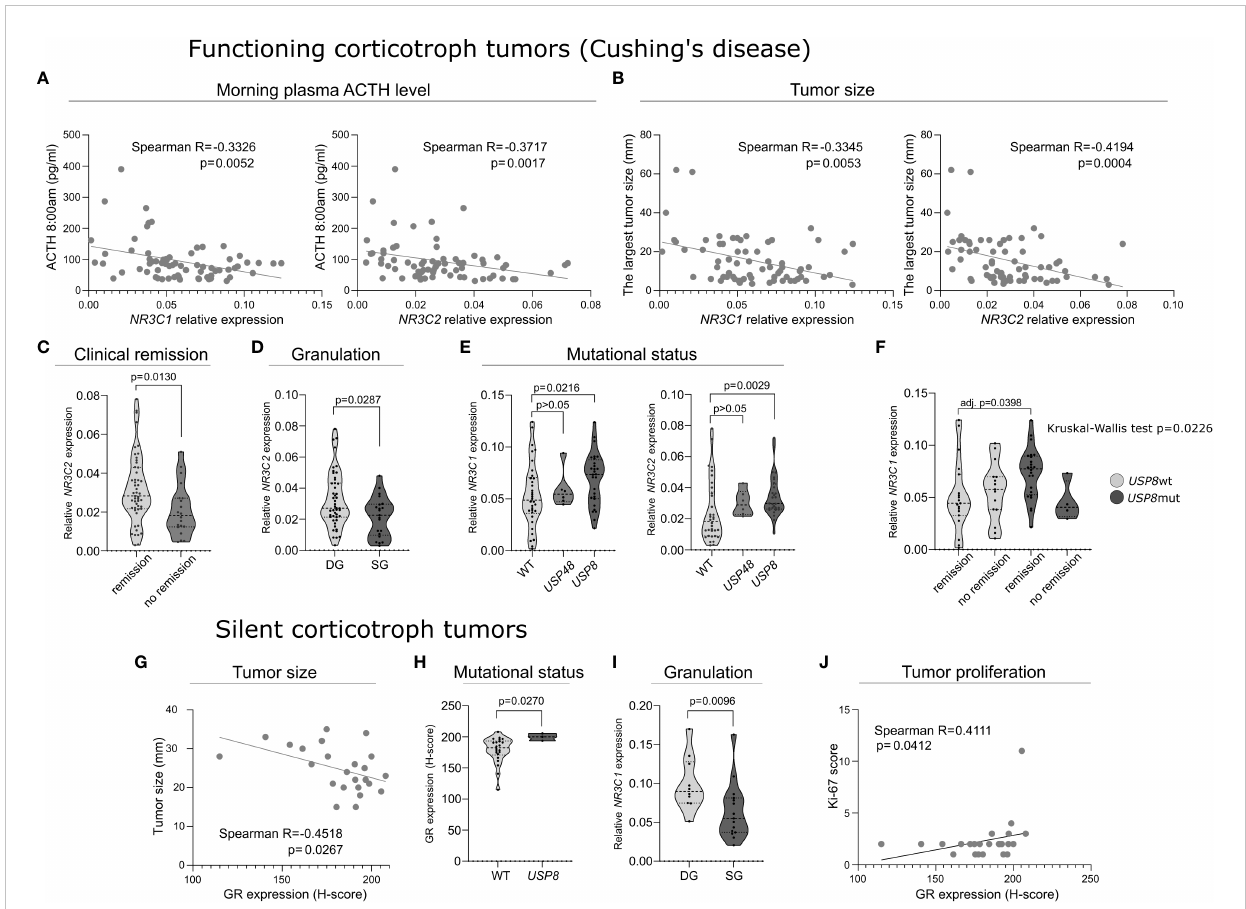
FIGURE 2 The expression of corticosteroid receptors ’ genes and proteins in functioning and silent corticotroph tumors. (A) The correlation between morning plasma ACTH level and the expression of NR3C1 and NR3C2 expression in tumor tissue in Cushing ’ s disease patients. (B) The correlation between tumor size and the expression of NR3C1 and NR3C2 in Cushing ’ s disease patients. (C) Difference in NR3C2 expression in tumors of Cushing ’ s disease patients with clinical remission after surgery and those without remission. (D) Difference in NR3C2 expression between densely granulated (DG) and sparsely granulated (SG) functioning corticotroph pituitary tumors. (E) Difference in the expression of NR3C1 and NR3C2 in tumors with mutations in deubiquitinase-encoding genes ( USP8 and USP48 ) and wild type functioning corticotroph pituitary tumors. (F) The expression of NR3C1 in patients with and without remission after surgery with respect to USP8 mutation status. (G) Correlation between the expression of glucocorticoid receptor (GR) and tumor size in silent corticotroph tumors. (H) GR expression in SCAs with and without USP8 mutation. (I) Difference in NR3C2 expression between densely granulated (DG) and sparsely granulated (SG) silent corticotroph pituitary tumors. (J) Correlation between GR expression and Ki-67 immunoreactivity score in silent